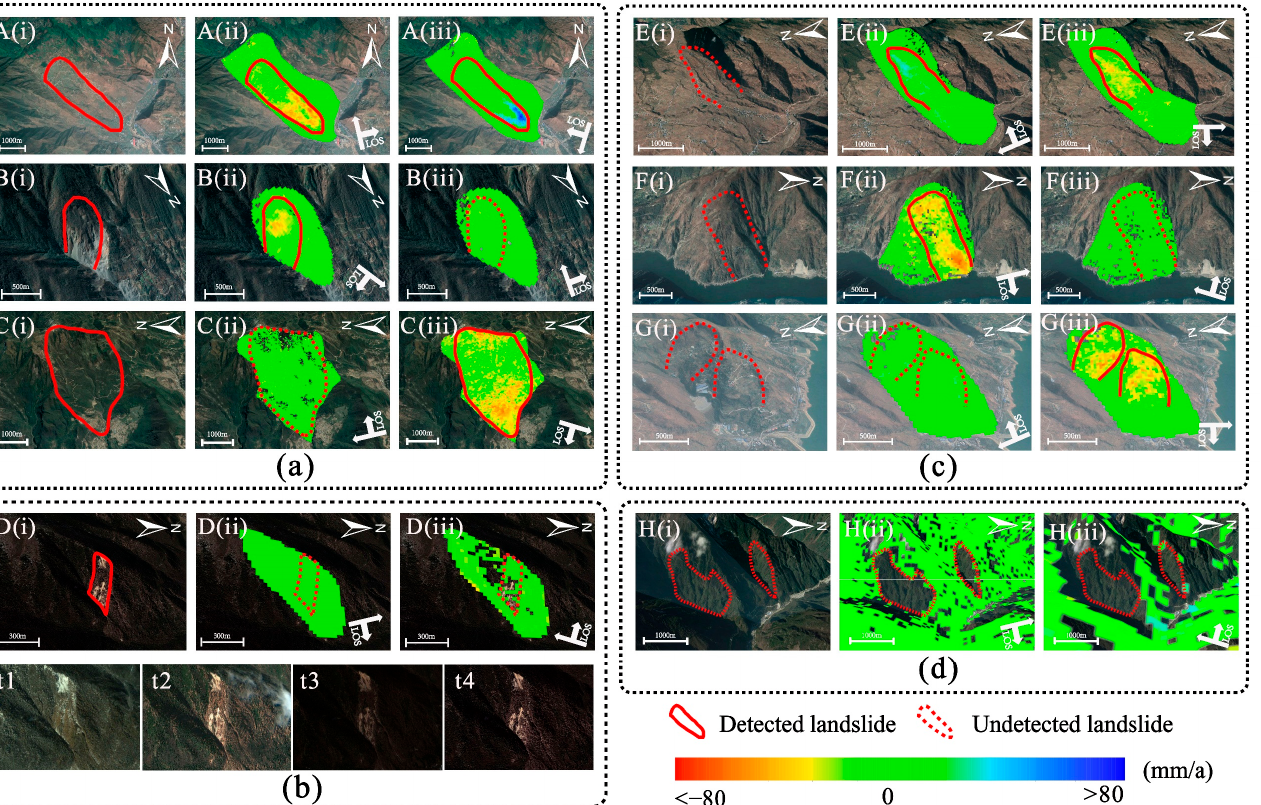
Figure 8. Hotspot analysis results: ( a ) and ( b ) represent hotspot analysis results of Zone 1 from as- cending and descending tracks, respectively, and ( c ) and ( d ) represent hotspot analysis results of Zone 2 from ascending and descending tracks, respectively.